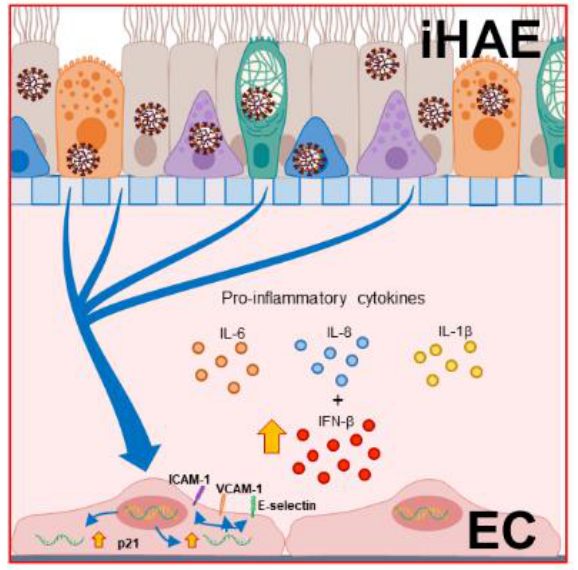
Figure 6. Proposed model of crosstalk between SARS-CoV-2 infected Human Airway Epithelium (iHAE) and Human Pulmonary Microvascular Endothelial Cells (ECs). Supplementary Materials: Figure S1: Replicative dynamics of SARS-CoV-2 in HAE (left panel) and ECs (right panel) in terms of cell-associated viral RNA at two and six days post infection (n=6 inde- pendent experiments); Figure S2: Correlation analysis between IFN- β expression and ICAM or VCAM-1 in ECs ; Figure S3: IFN- β levels released during SARS-CoV-2 infection of HAE in co-cul- ture with ECs (iHAE-Ec) after H-151 (or vehicle) addition to the basal chamber. The following supporting information can be downloaded at: www.mdpi.com/xxx/s1, Figure S1: